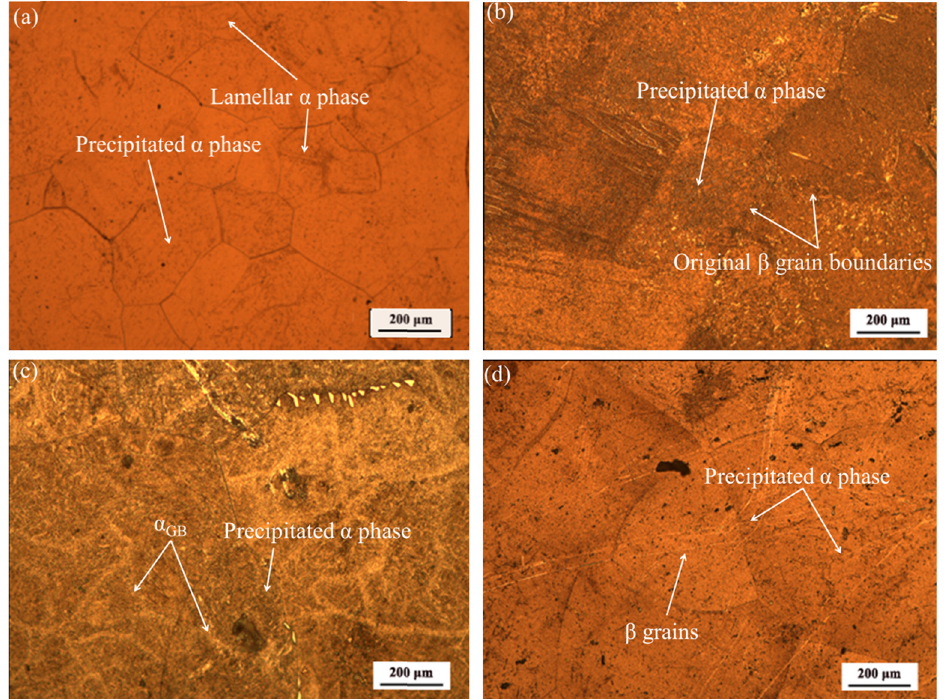
Figure 5: Microstructures of sample solutions aging - treated at solution temperatures of ( a ) 700°C, ( b ) 760°C, ( c ) 820°C and ( d ) 880°C and the aging temperature of